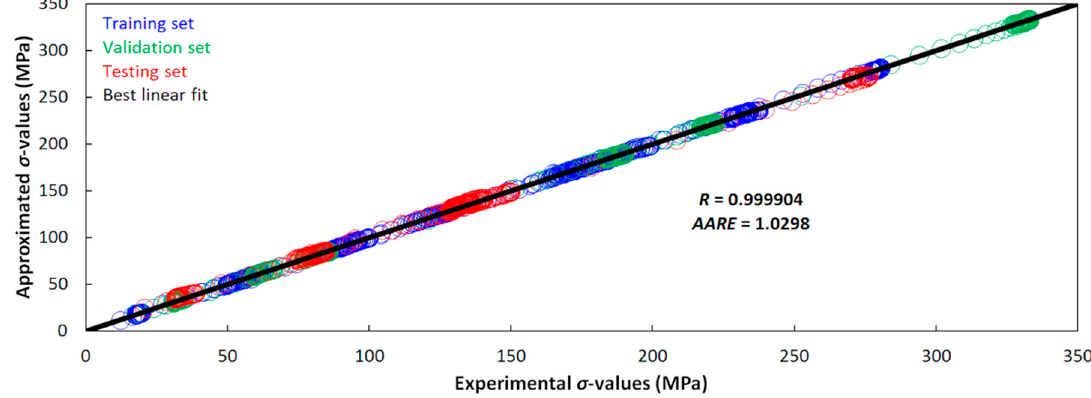
Figure 2. Correlation between the experimental and by-MLP approximated flow curve datasets.